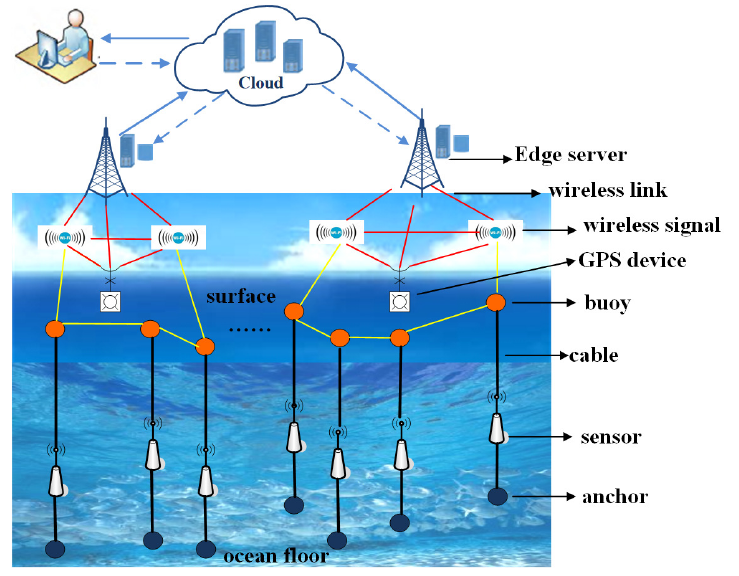
Figure A3. Underwater sensor deployment